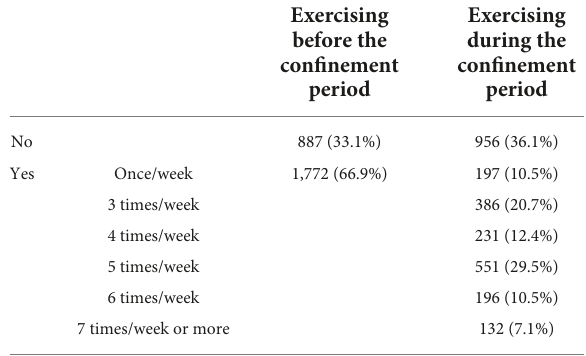
TABLE 3 Exercising before and during the confinement